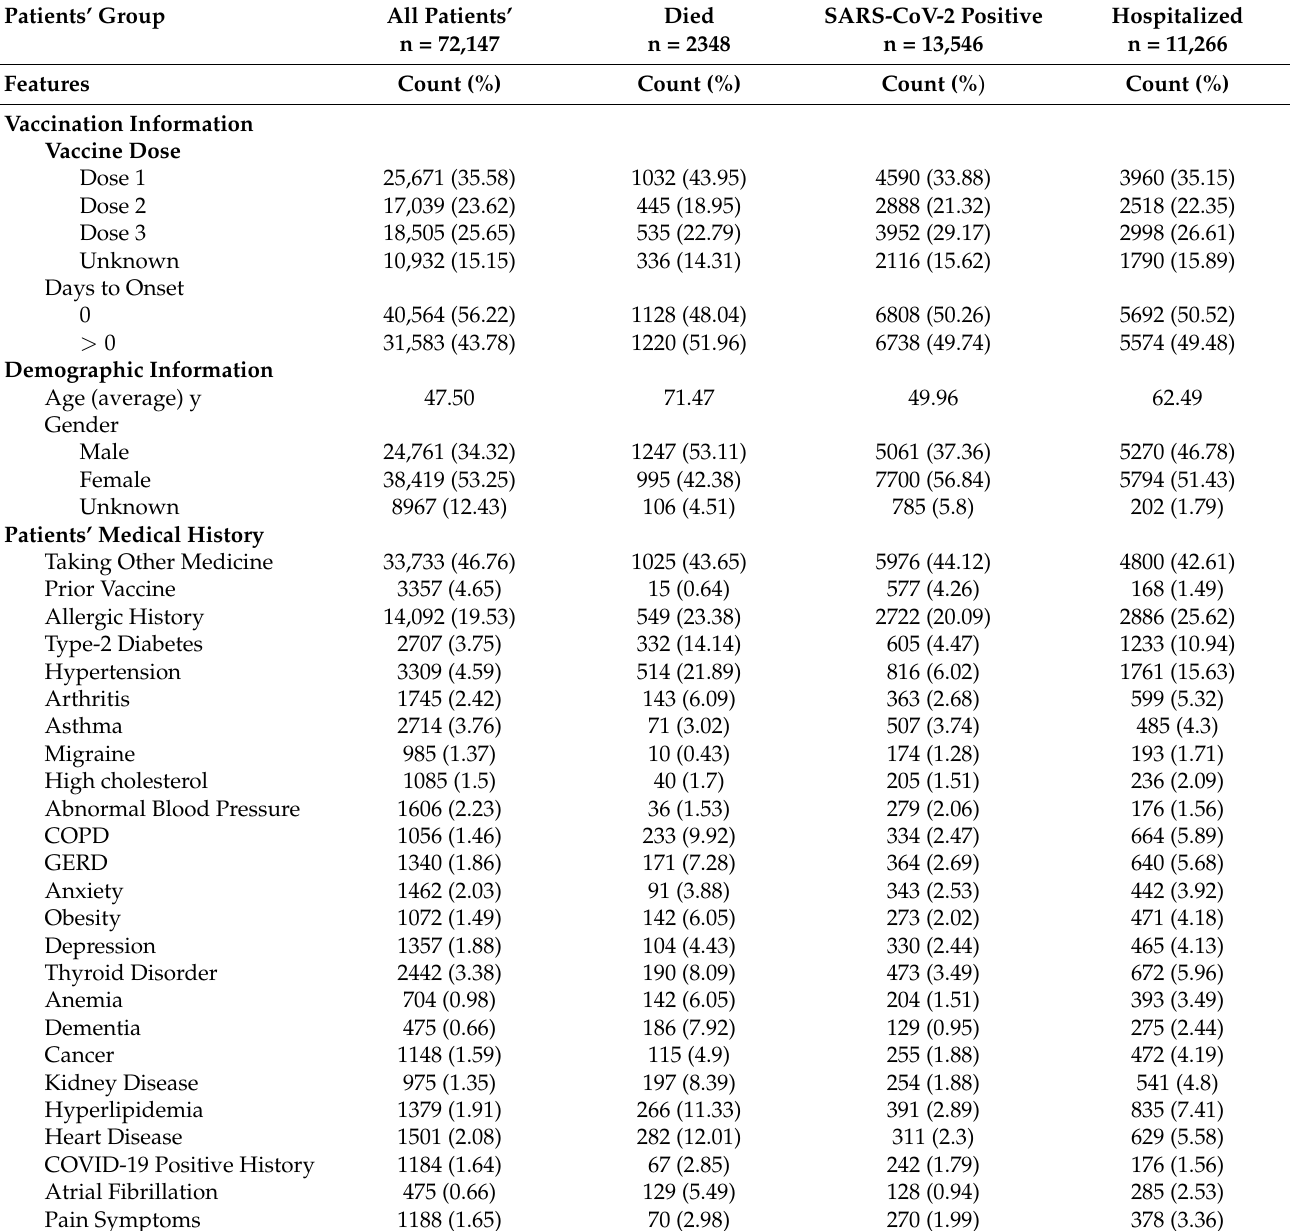
Table 1. The vaccination, demographic and patients’ medical